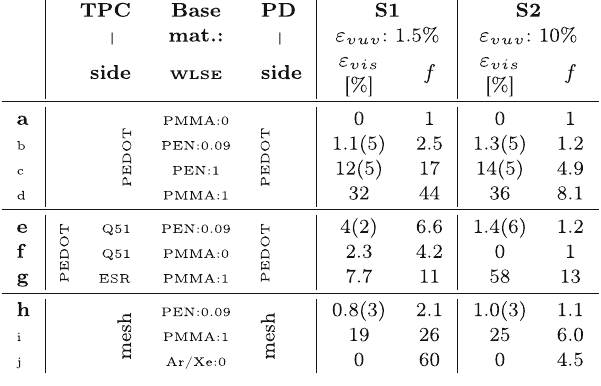
aeus). Otherwise, the geometry of the tiles follows the